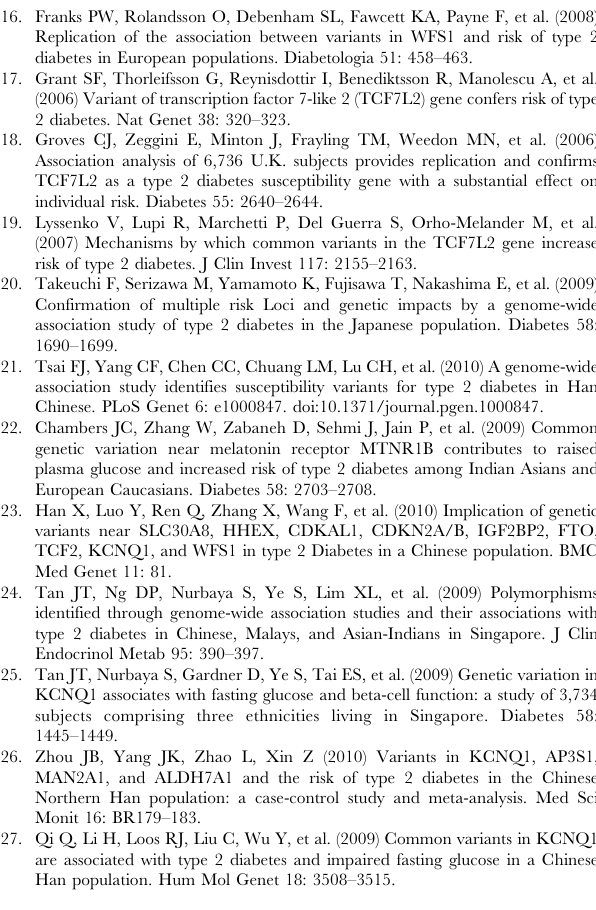
Table S4 Monte-Carlo P -values from varLD algorithm for the 36 established T2D susceptibility loci, comparing the European panel of Hapmap II (CEU) with Chinese (CHS), Malays (MAS)